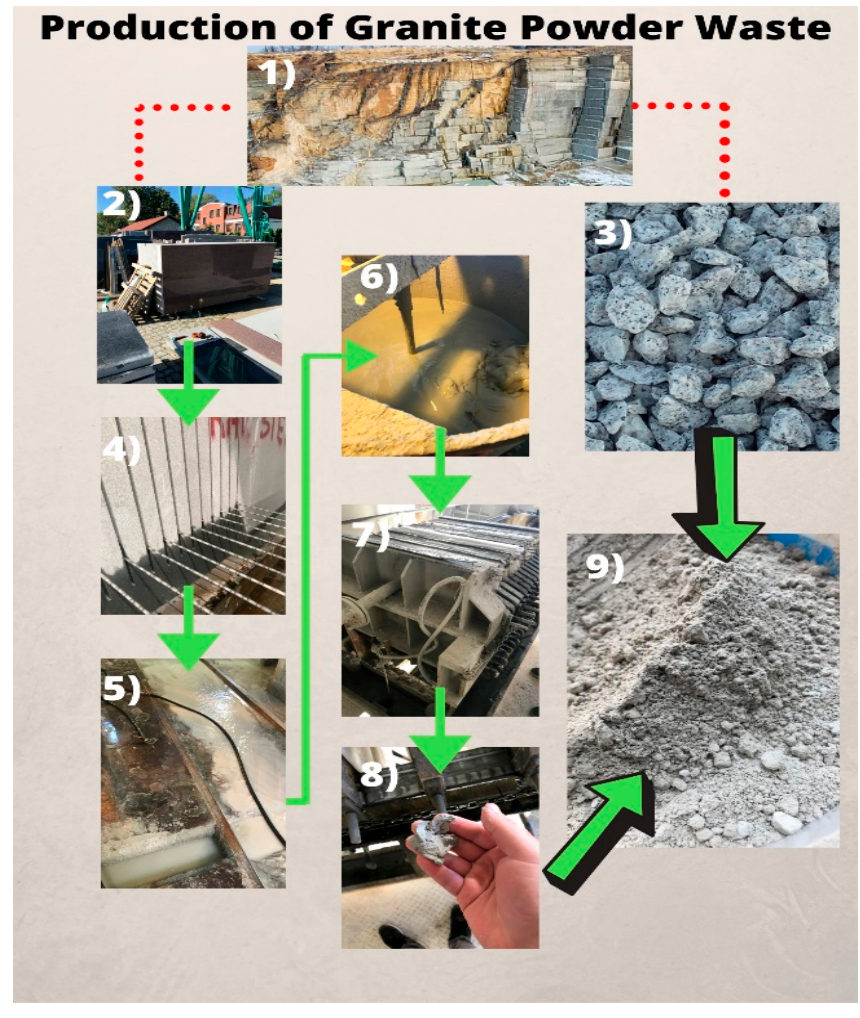
Figure 1. Production of granite powder waste .